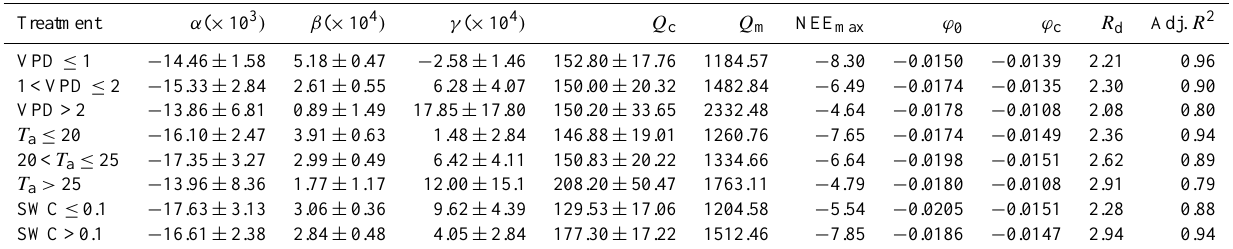
Table 2. Parameter values describing the response of daytime NEE to incident PAR during the peak growing season (June–August) under different environmental